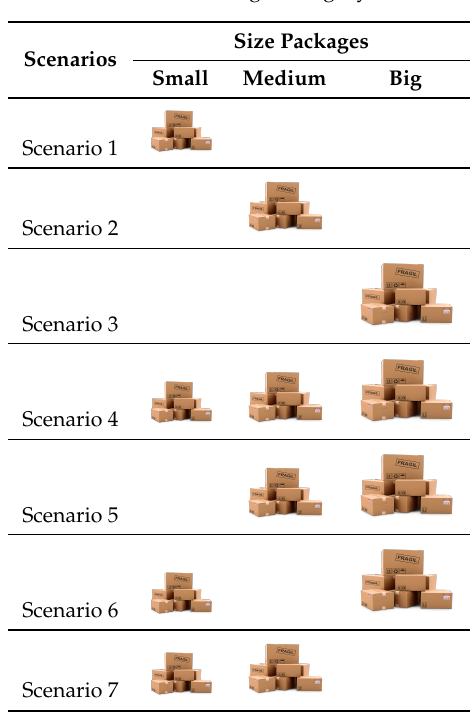
Table 2. Package